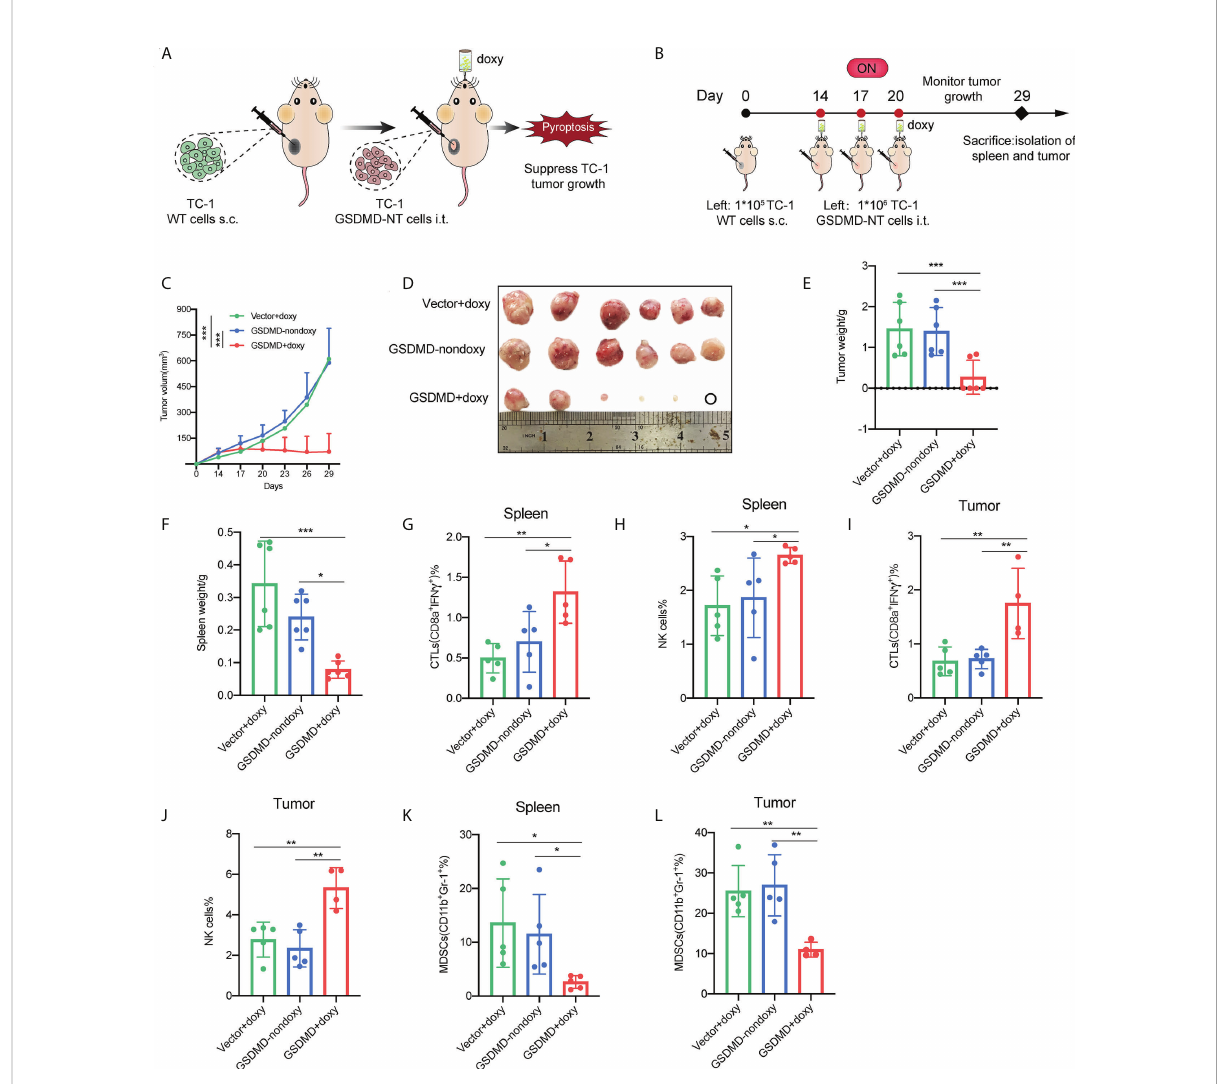
FIGURE 6 Local inoculation with the pyroptosis-inducible tumor cells suppresses the growth of established TC-1 tumors and signi fi cantly improves the antitumor cellular immune responses. (A) Schematic representation of the treatment of TC-1 xenograft tumors by local inoculation of the pyroptosis-inducible tumor cells. (B) The experimental protocol (n=6). (C) Tumor growth curves by groups. (D) The size of the tumor mass. (E) The weight of the tumor mass. (F) The weight of the spleen. (G – L) CTLs (IFN g + CD8 a + ), natural killer cells (NK1.1 + ), and MDSCs (CD11b + Gr- 1 + ) in the spleen (G, H, K) and tumor tissues (I, J, L) were analyzed by fl ow cytometry (n=5). (C, E – L) Graph shows means ± SD, One-way ANOVA, * p value < 0.05, ** p value < 0.01, *** p value <